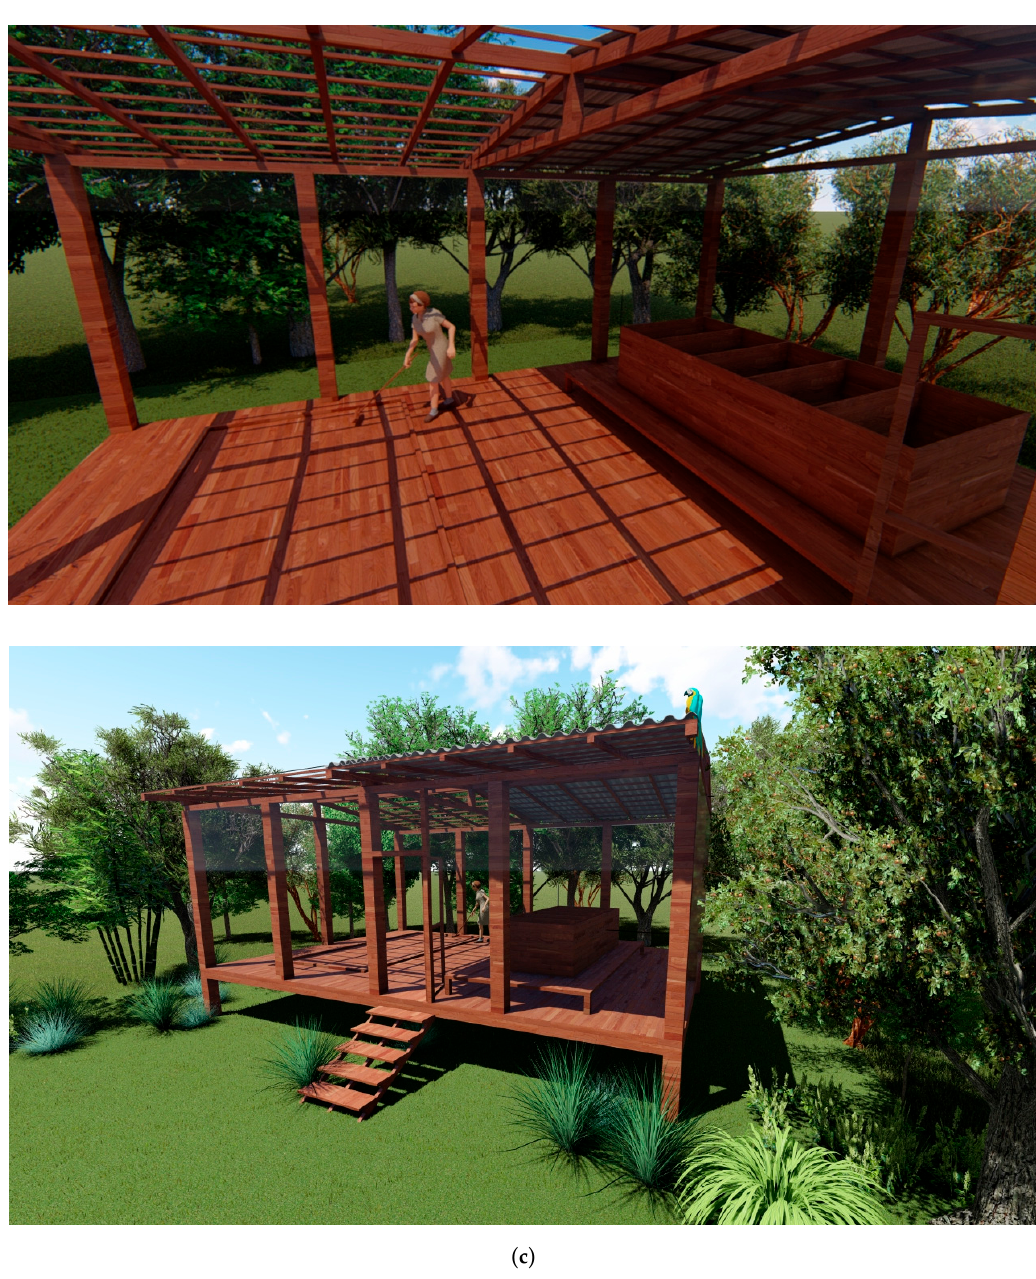
Figure 4. Project design of the ( a ) wood fermenter, ( b ) delimiter/separator of the solar drier terrace made up of four wooden sticks, and ( c ) the suspended greenhouse structure made of wood, side walls of plastic and roof with plastic and cement tiles. The dimensions L × l × h, where “L” is the length, “l” is the width or depth, and “h” is the height were: ( a ) Wood fermenter (3.12 × 1.04 × 1.02) m, each of the five fermenter compartments/boxes (0.62 × 1.04 × 1.02) m, and the bottom of the fermenter with 1-cm ϕ holes to drain liquids; ( b ) Delimiter of the solar drier terrace (2.30 × 4.50) m made up of wooden sticks (l × h) (0.050 × 0.050) m; and ( c ) Greenhouse structure (L × h) (9.0 × 6.0), h and h ma× from the floor to roof of 3.10 and 3.75 mm, respectively, and a greenhouse suspended with four piles of 0.80 m high (from the ground to the floor).